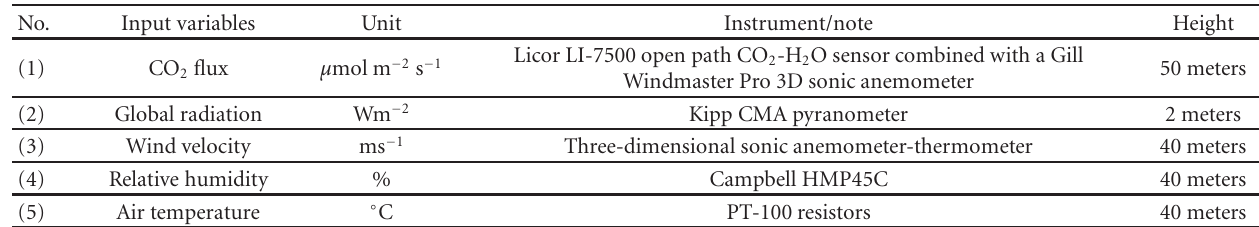
Table 1: Input variables used for gap